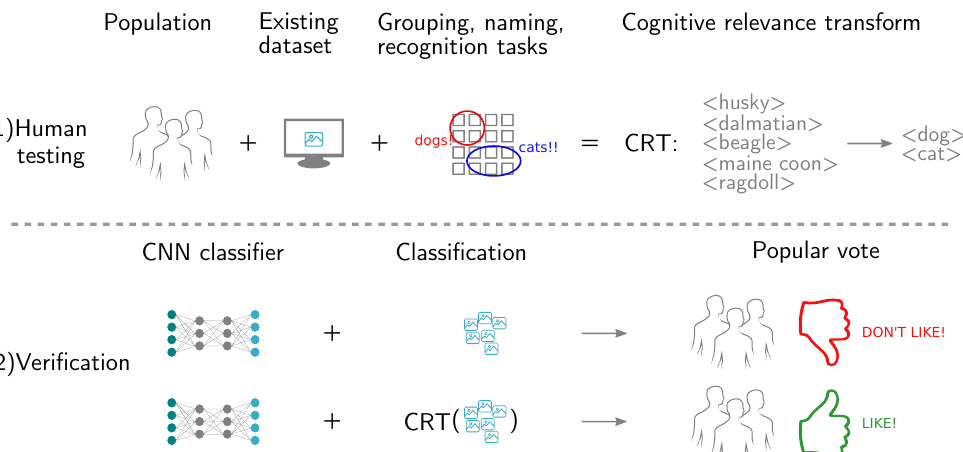
Figure 2. Main idea of this work. Images from the existing dataset are shown to the target population. Members of a population perform grouping, category naming, and recognition tasks on a subset of images. The results are used to find a Cognitive Relevance Transform (CRT) that modifies the number, grouping, and naming of categories. The CRT is population-specific and introduces bias into the transformed dataset. As a result, even a disjointed group of people, sampled from the same population, prefers the classification results on the transformed dataset, compared to the results on the original dataset.